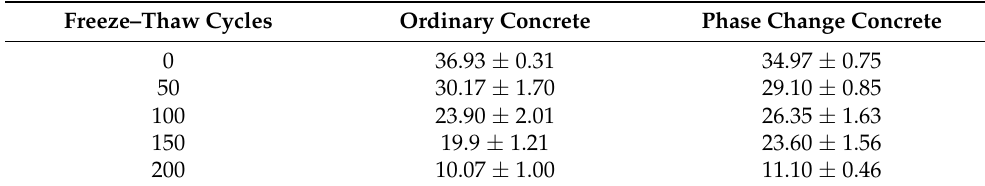
Figure 8. Comparison of relative dynamic elastic modulus. Table 12. Compressive strength of concrete during freezing and thawing (MPa).